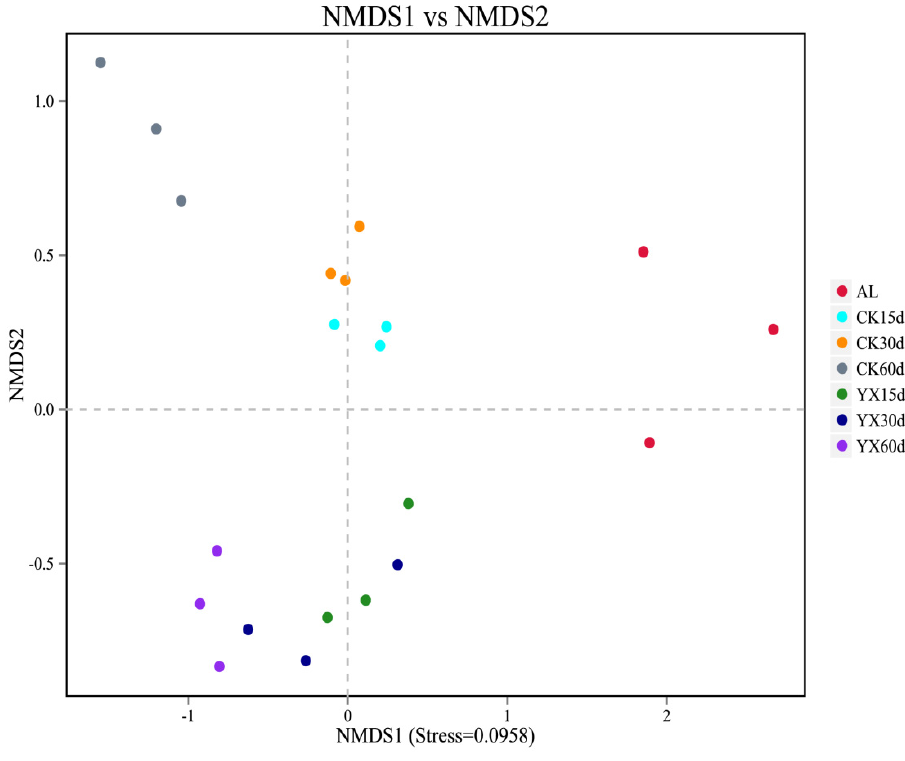
Figure 4. Non–metric multidimensional scaling (NMDS) plot based on OTU level in alfalfa silage. AL, alfalfa material before ensiling; CK, control; YX, inoculated with commercial LAB YX; the numbers following CK and YX stand for ensiled days of silage.